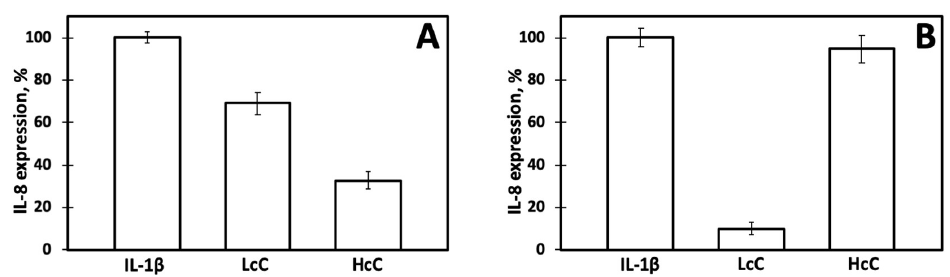
Figure 4. IL-8 relative expression in Caco-2 cells incubated with LcC or HcC (0.5 mg / mL) under di ff erent experimental conditions. Response to IL-1 β alone was set as 100%. ( A ) LcC or HcC was added to the cell medium 30 min before the addition of IL-1 β and then incubated for 1h. ( B ) LcC or HcC was first